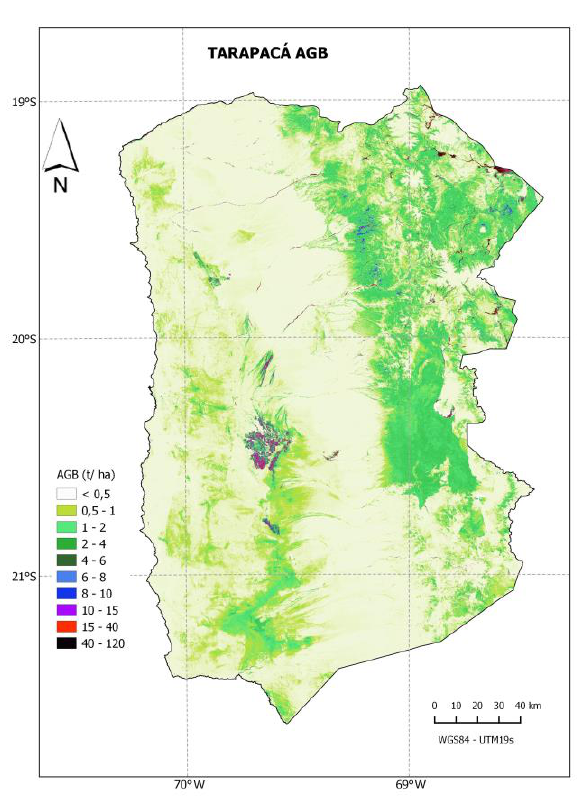
Figure 6. Predicted ABG for the whole Tarapacá